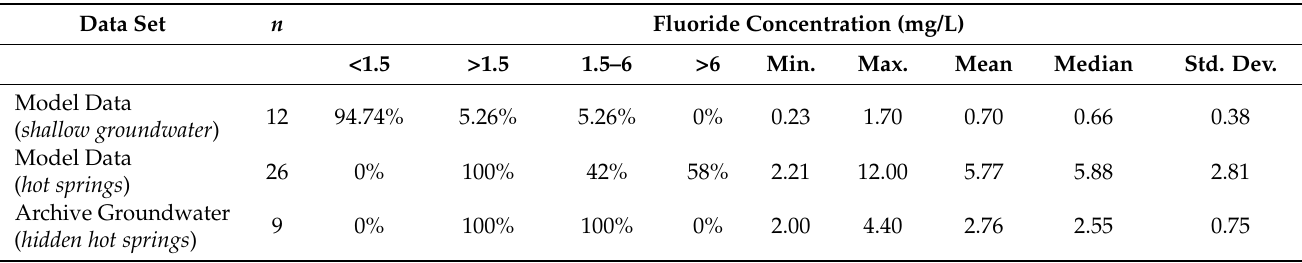
Table 2. Summary statistics of groundwater fluoride concentrations from the model data (hot springs and shallow groundwater shown separately), and hidden hot springs identified from the archive groundwater data